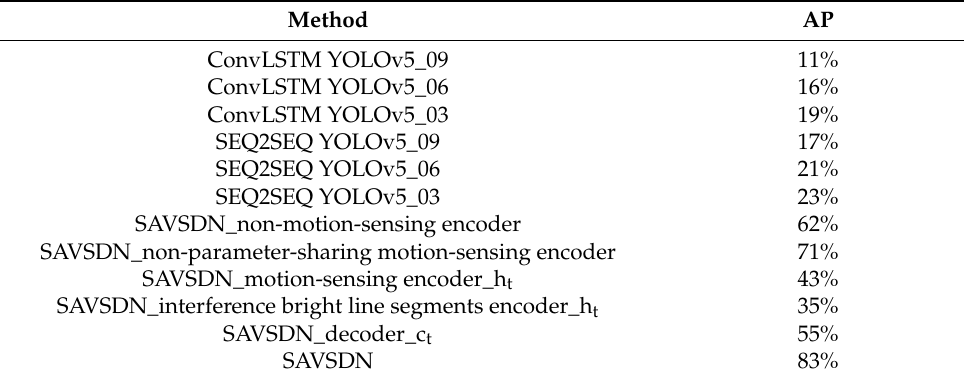
Table 1. Ablation studies and the corresponding performance for spark